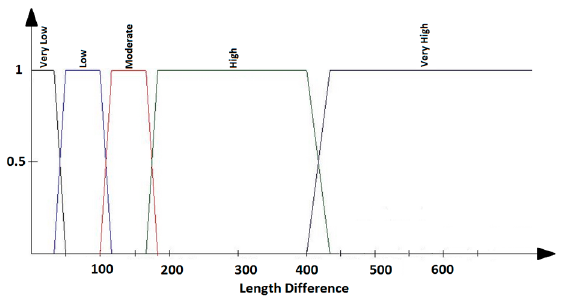
Fig. 12. Membership functions of length difference